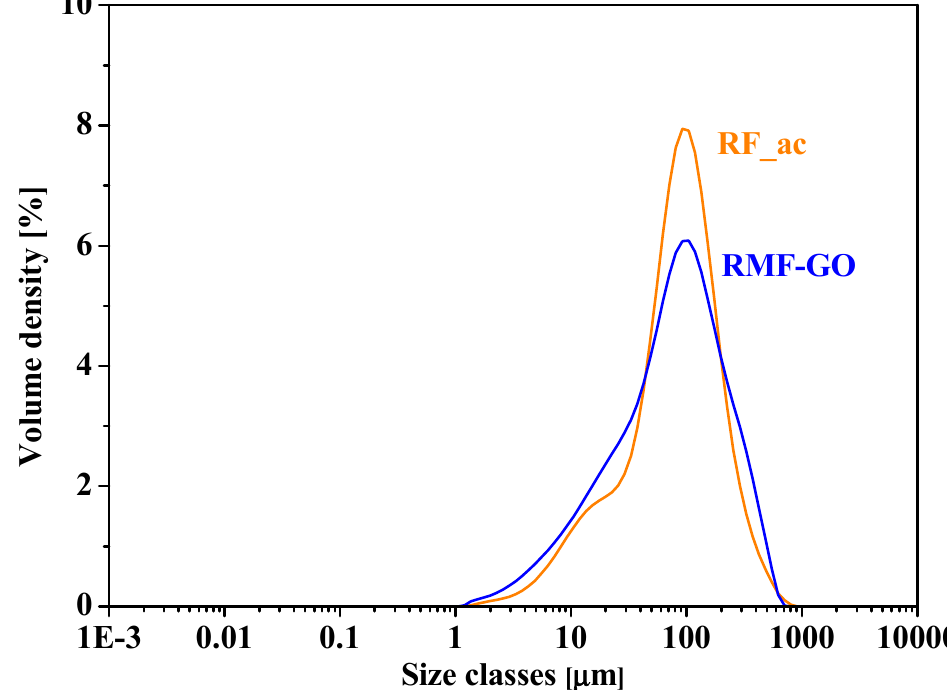
Figure 3. Particle size distribution of RF_ac (orange) and RMF-GO (blue) carbon aerogels.